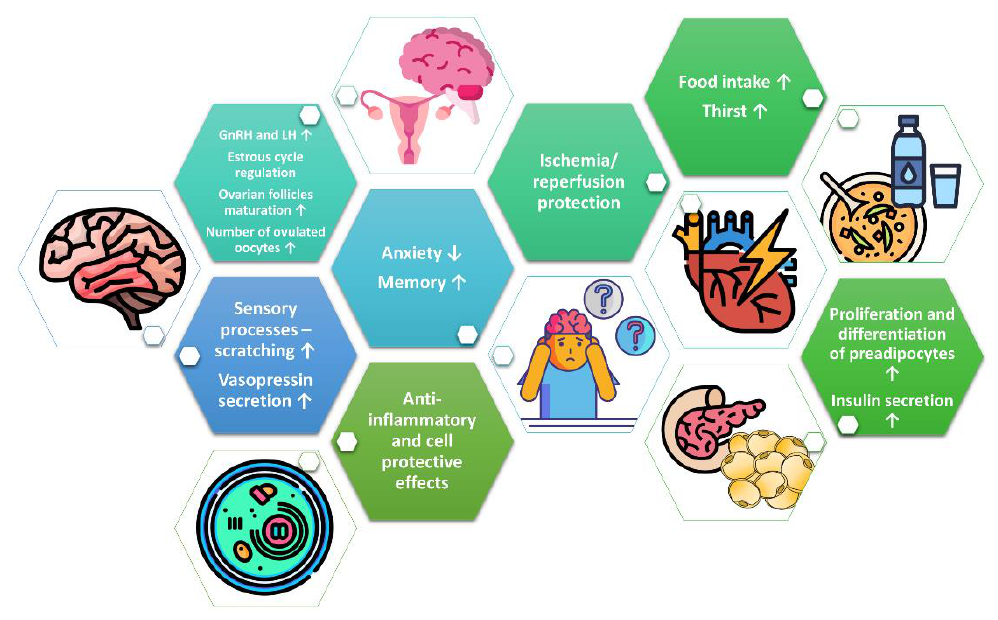
Figure 2. Summary of the biological effects of PNX.